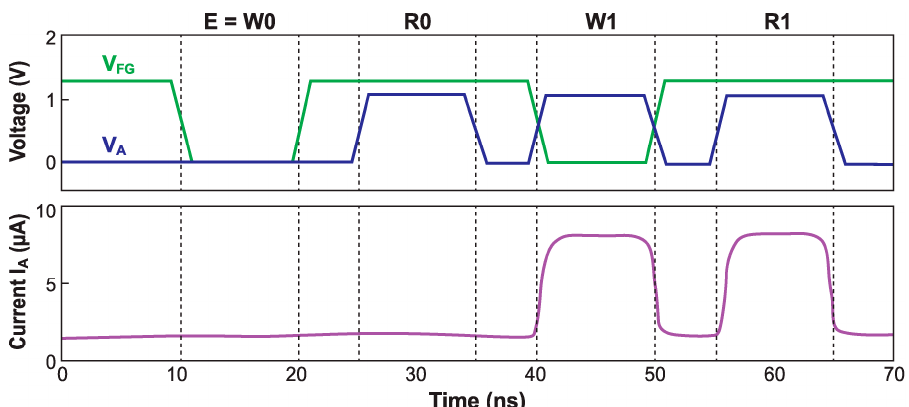
Figure 18. Z 2 –FET dynamic memory operation consisting of a E-R-W-R sequence. The hold operation (not indicated) is performed by default after any other operation. The cell drives current only for the ‘1’-state programming (W1) and readout